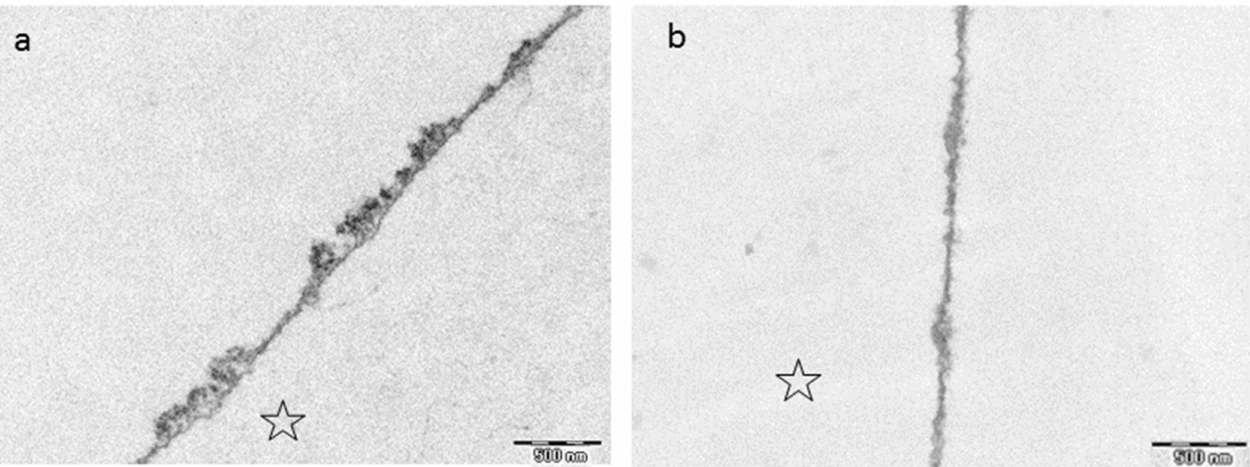
Figure 8. TEM images visualizing the effect of cistus incanus tea on the in situ pellicle layer after rinsing with 8 mL of cistus incanus tea for 10 min (Wittpahl et al. (2015) [63]). ( a ) shows the results after 30 min, ( b ) after 120 min. The former enamel site was marked with an